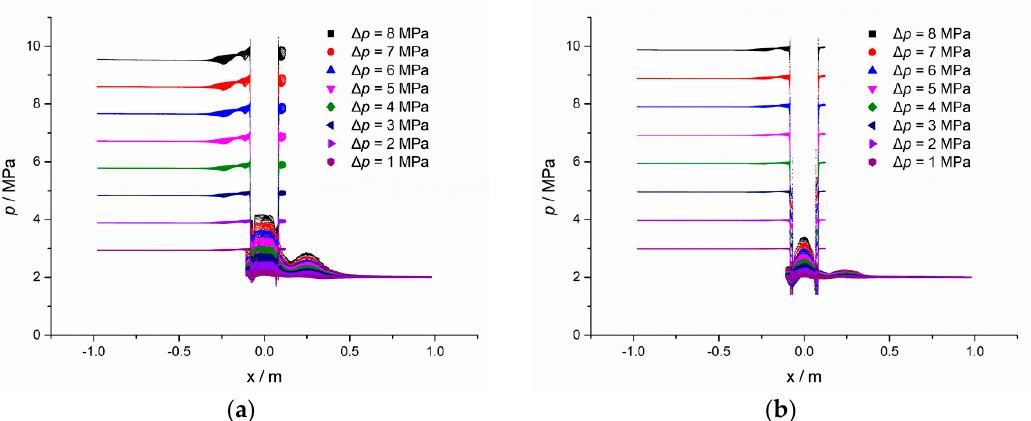
Figure 7. Pressure variation along the horizontal direction for different pressure differences ( a ) L = Figure7. Pressurevariationalongthehorizontaldirectionfordi ff erentpressuredi ff erences( a )L = 60mm; 60 mm; ( b ) L = 30 mm. ( b ) L = 30